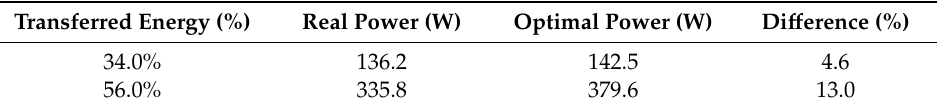
Table 2. Electrical power output as function of heat recovery